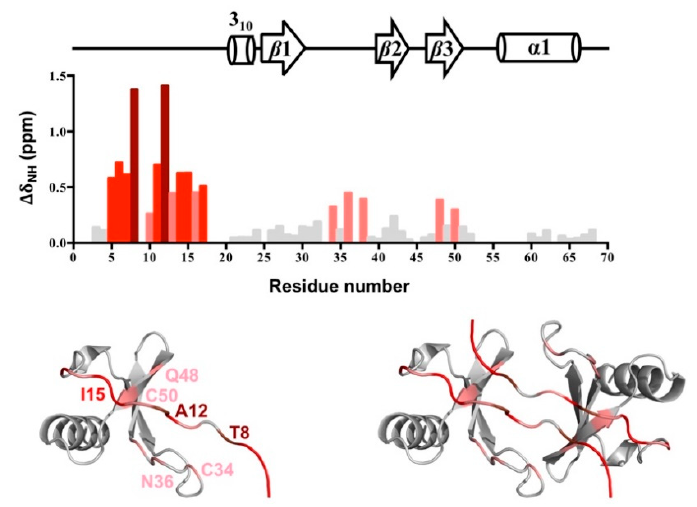
Figure 7. Chemical shift di ff erences between CCL5- 12 AAA 14 and wild-type CCL5. Chemical shift di ff erence ( ∆ δ NH ) represents the combined chemical shift di ff erence of the amide and amide proton between the CCL5- 12 AAA 14 dimer and the wild-type CCL5 dimer. Residues with ∆ δ NH > 0.25 ppm are colored by pink, > 0.5 ppm by red, and > 1.0 ppm by brown. The residues are mapped on the monomer unit and dimer structure of CCL5- 12 AAA 14 with the same color scheme.